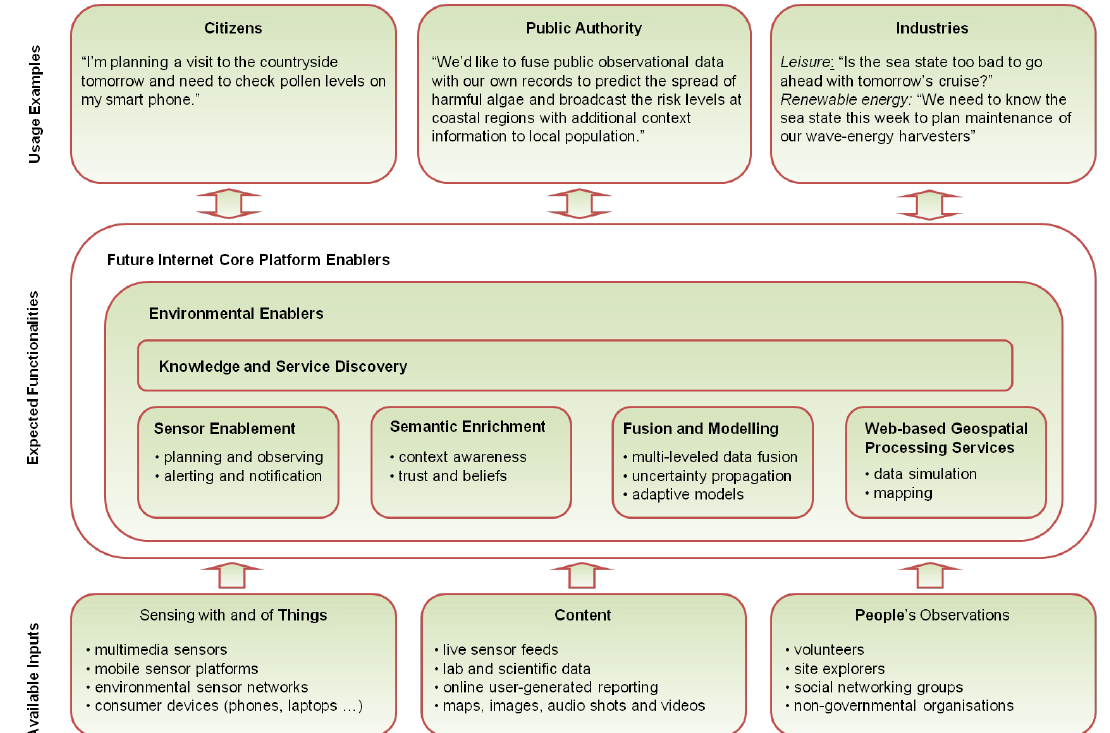
Figure 5. Overview of the envirofied Future Internet and its collaborating stakeholder